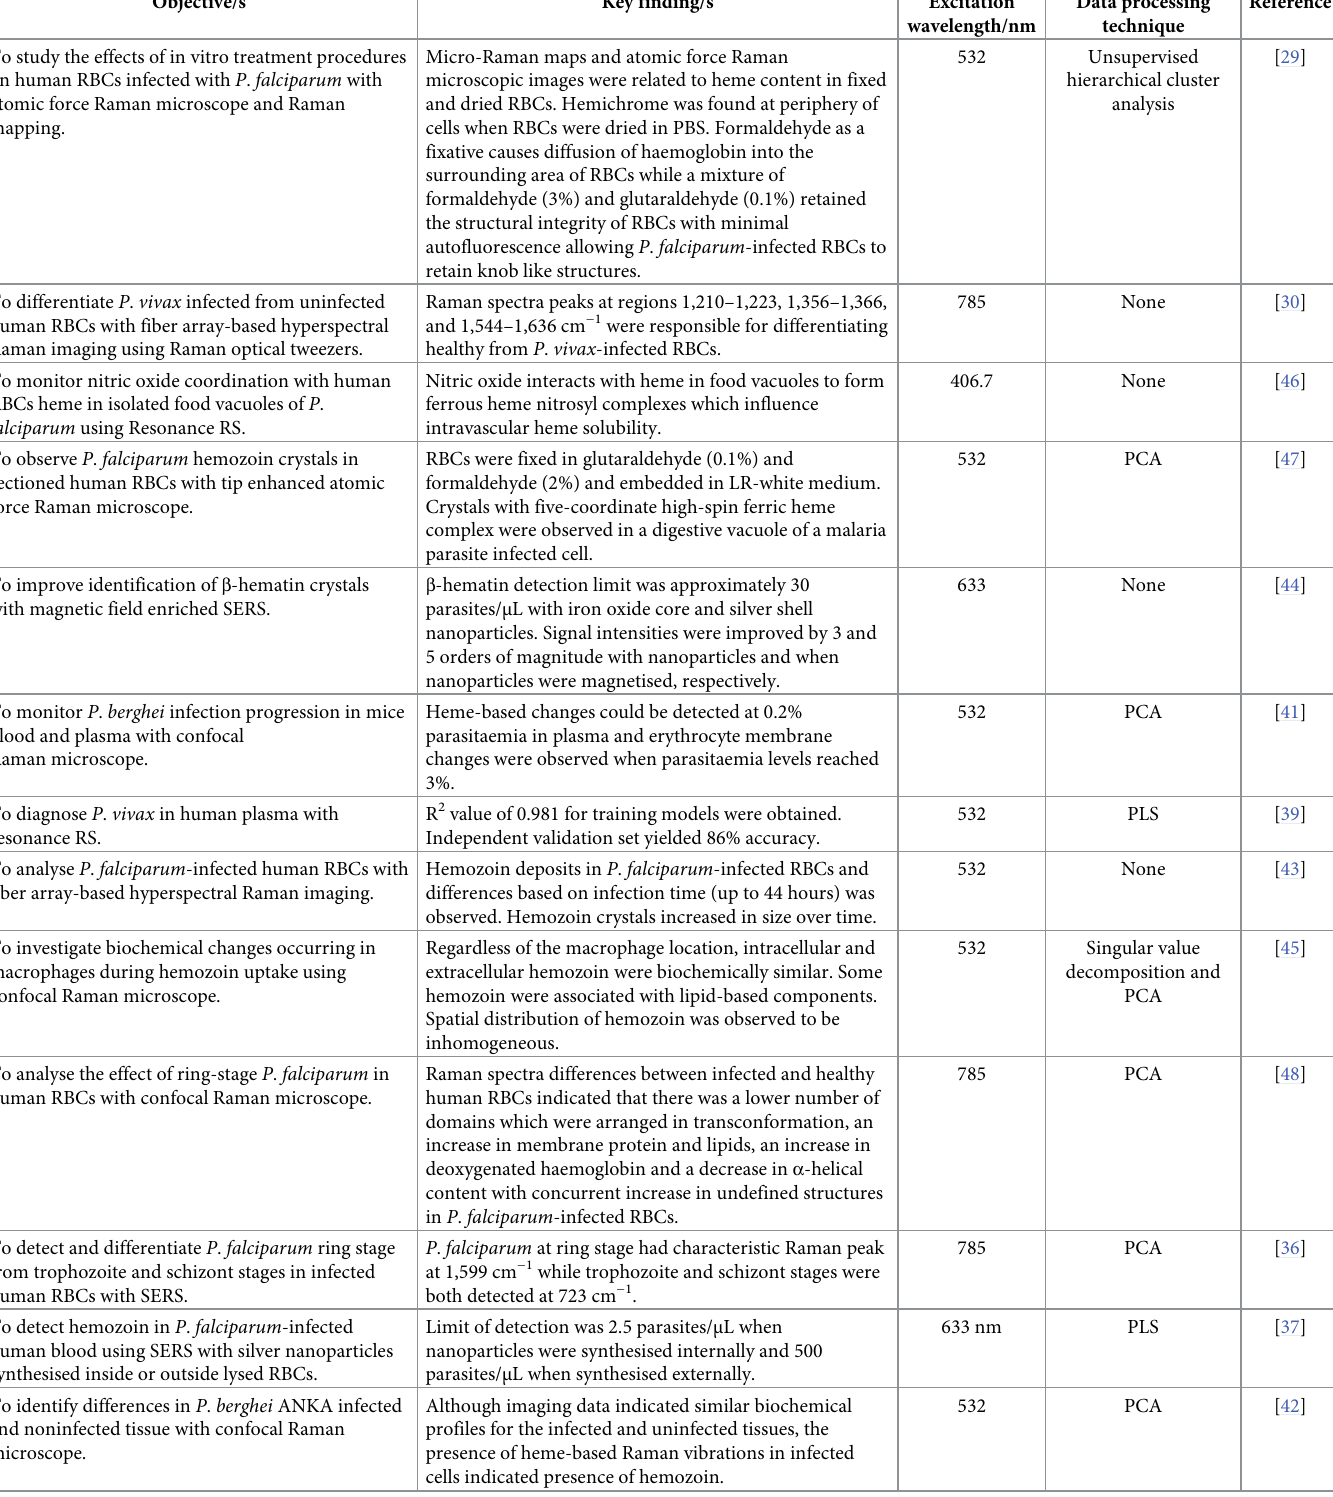
Table 2. A summary of articles reviewed that applied RS for the diagnosis of malaria parasite. Objective/s Key finding/s Excitation